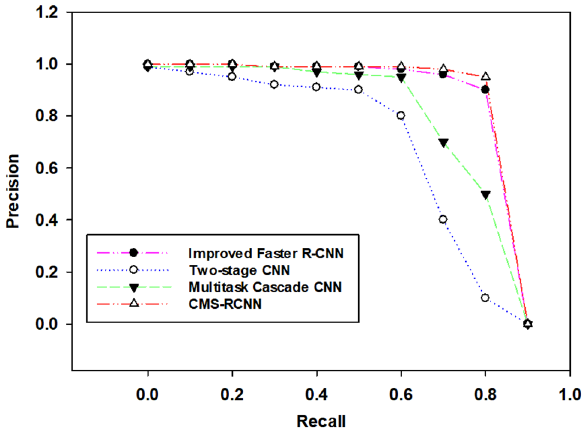
Figure 5. Comparison of the missing part detection module with state-of-the-art methods on our testing dataset.